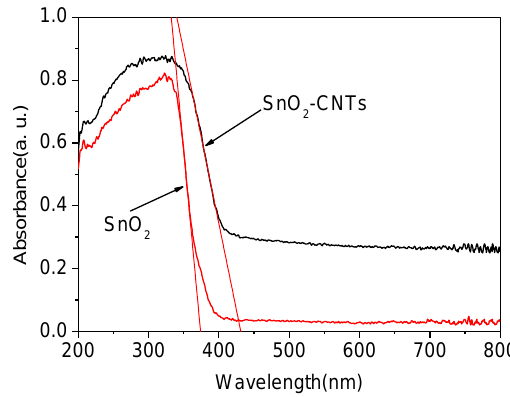
Figure 4. Ultraviolet-visible diffuse reflection (UV-Vis DRS) spectra of SnO 2 -CNTs and SnO 2 . photocatalytic oxidation of RhB dye. Figure 5a shows that the spectrum changes during RhB (10 − 5 mol/L) photodegradation by SnO 2 -CNTs with different reaction time. The normalized temporal concentration changes ( C / C 0 ) of RhB during the photocatalytic process are proportional to the normalized maximum absorbance ( A / A 0 ), as can be derived from the change in the RhB absorption profile at a given time interval. The blank experiments show that the degradation of RhB is less than 5% only under visible light irradiation at 150 min (Figure 5b). With the increase of irradiation time, degradation of the RhB dye solutions. When SnO 2 -CNTs nanocomposites were used as photocatalysts, the degradation of RhB reached 95.60% after 150 min, which is much higher than pure SnO 2 , with 64.4% degradation of